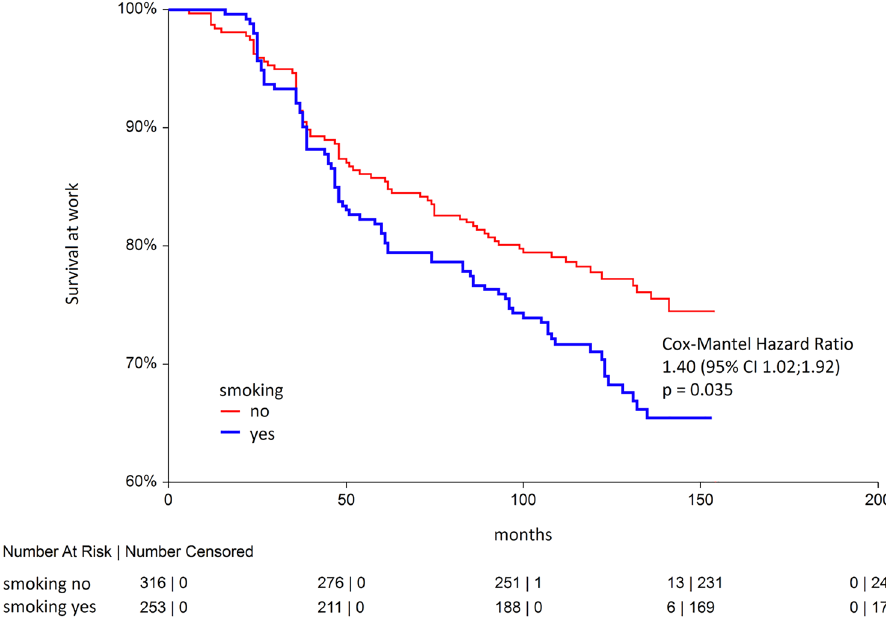
Figure 1. Kaplan–Meier curves for smokers and non-smokers in a prospective observation.